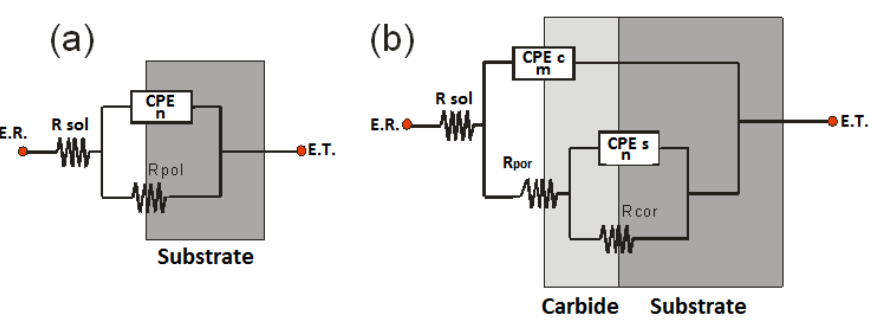
Figure 11. Equivalent circuits for electrochemical impedance spectroscopy (EIS) tests. ( a ) substrate ( b ) coating. Table 5. Values of the parameters obtained after the fit of the proposed equivalent circuits to the coatings produced, after exposure times of 168 h. CPE: constant phase element.